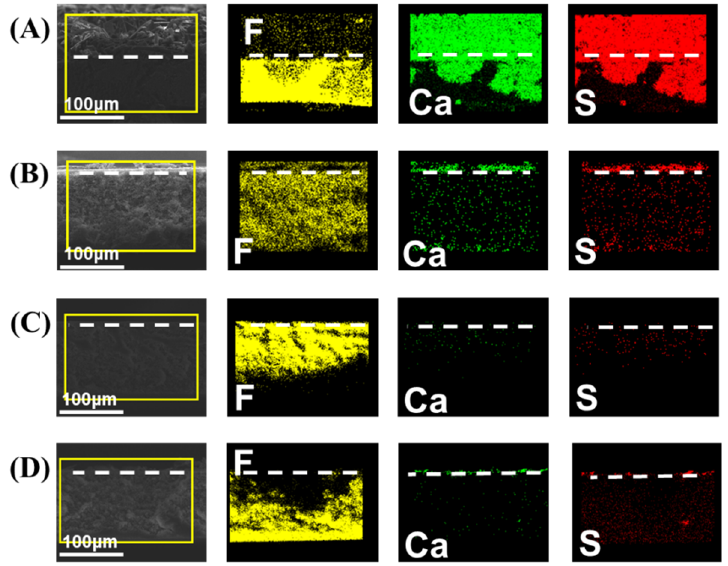
Figure 6. The cross-section of SEM and elemental mapping images of ( A ) pristine, ( B ) P-1, ( C ) P-2, and ( D ) P-3.